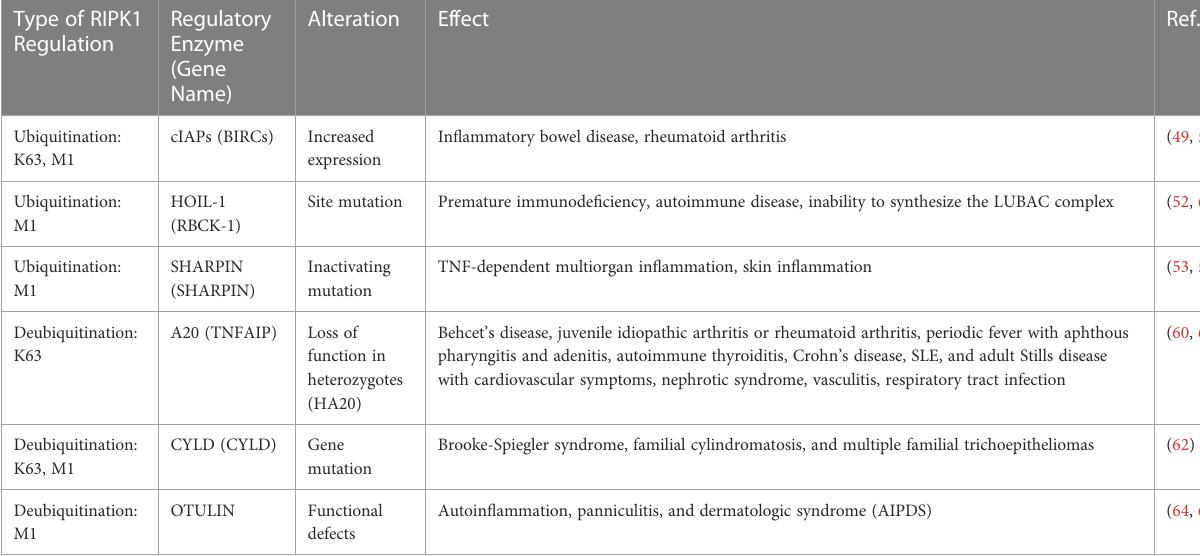
TABLE 2 Ubiquitinases and deubiquitinases of RIPK1 and its effect. Type of RIPK1 Regulation